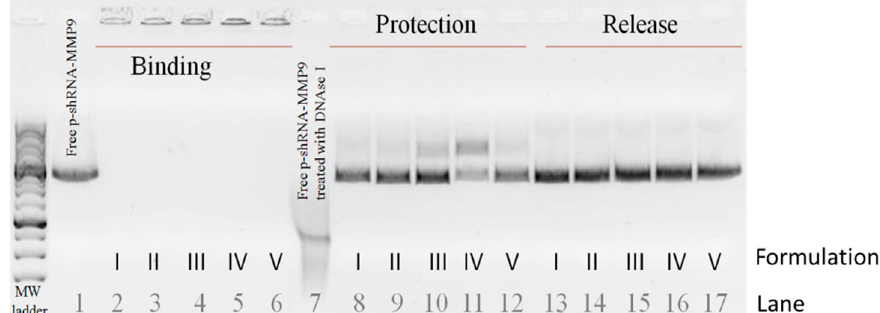
Figure 2. The agarose gel electrophoresis study of the capacity of the vectors to bind, protect, and release the p-shRNA-MMP-9. Lane 1: free p-shRNA-MMP-9; lanes 2 to 6: binding; lane 7: free p-shRNA-MMP-9 treated with DNase I; lanes 8 to 12: vectors treated with DNase I; lanes 13 to 17: vectors treated with SDS (induced release). Molecular weight (MW) ladder corresponds to the 1 kb DNA ladder from NIPPON Genetics Europe (Dueren, Germany).